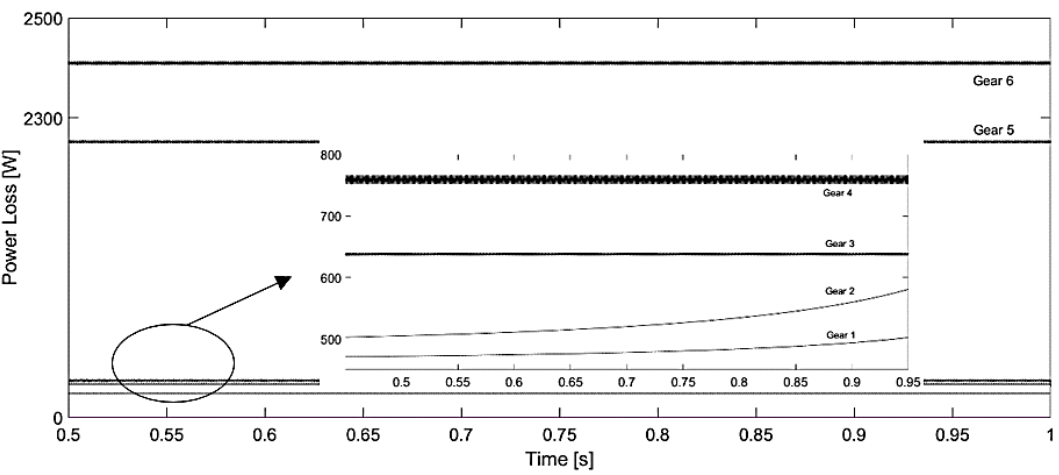
Figure 12. Power losses for WCC coated gears, scenario 1.